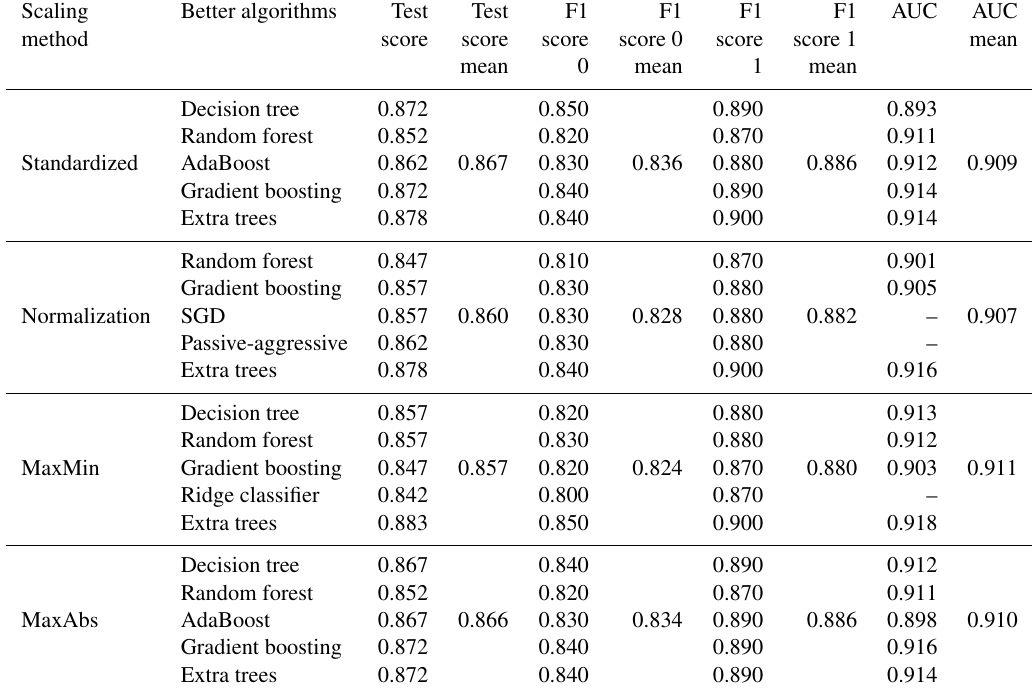
Table 2. Results of the top five algorithms for each scaling method. Refer to section 2.6 for the definition of each metric: test score is the optimized test score, an F1 score of 0 means that the F1 score is false, an F1 score of 1 means that the F1 score is true and AUC refers to the area under the curve. The mean of each metric has been calculated for the different reclassification methods to compare the